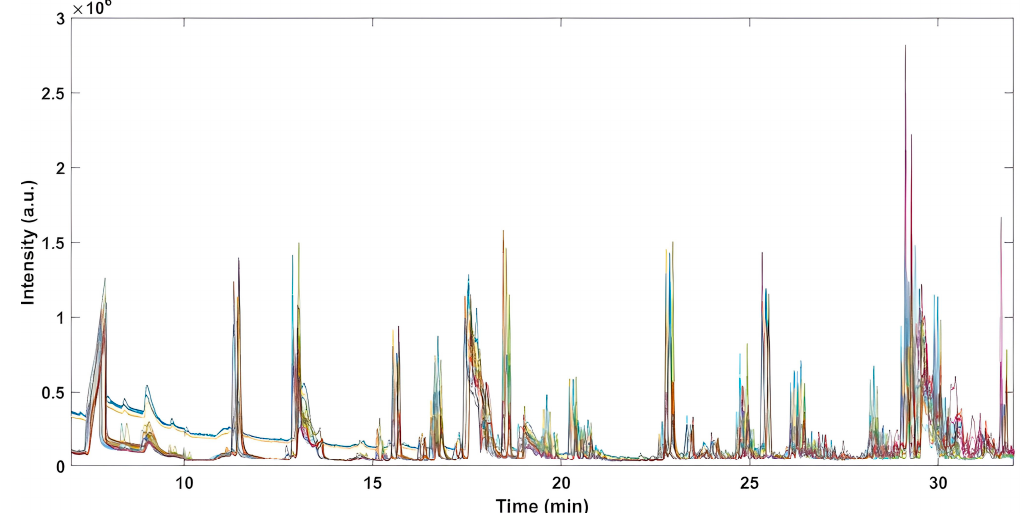
Figure 1. Investigated interval of raw chromatograms (from 7 to 37